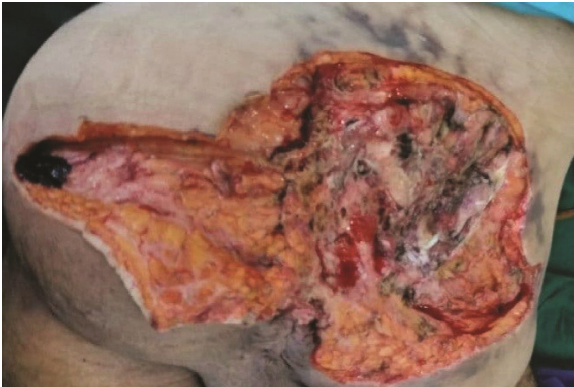
Figure 2. Complete Removal of the Mass Along With the Soft Tissue of the Guttural Area.